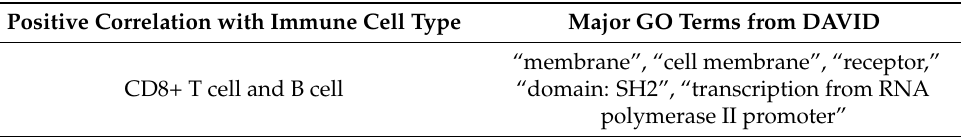
Table 4. Gene ontology (GO) terms of genes with positive correlation with different immune cell